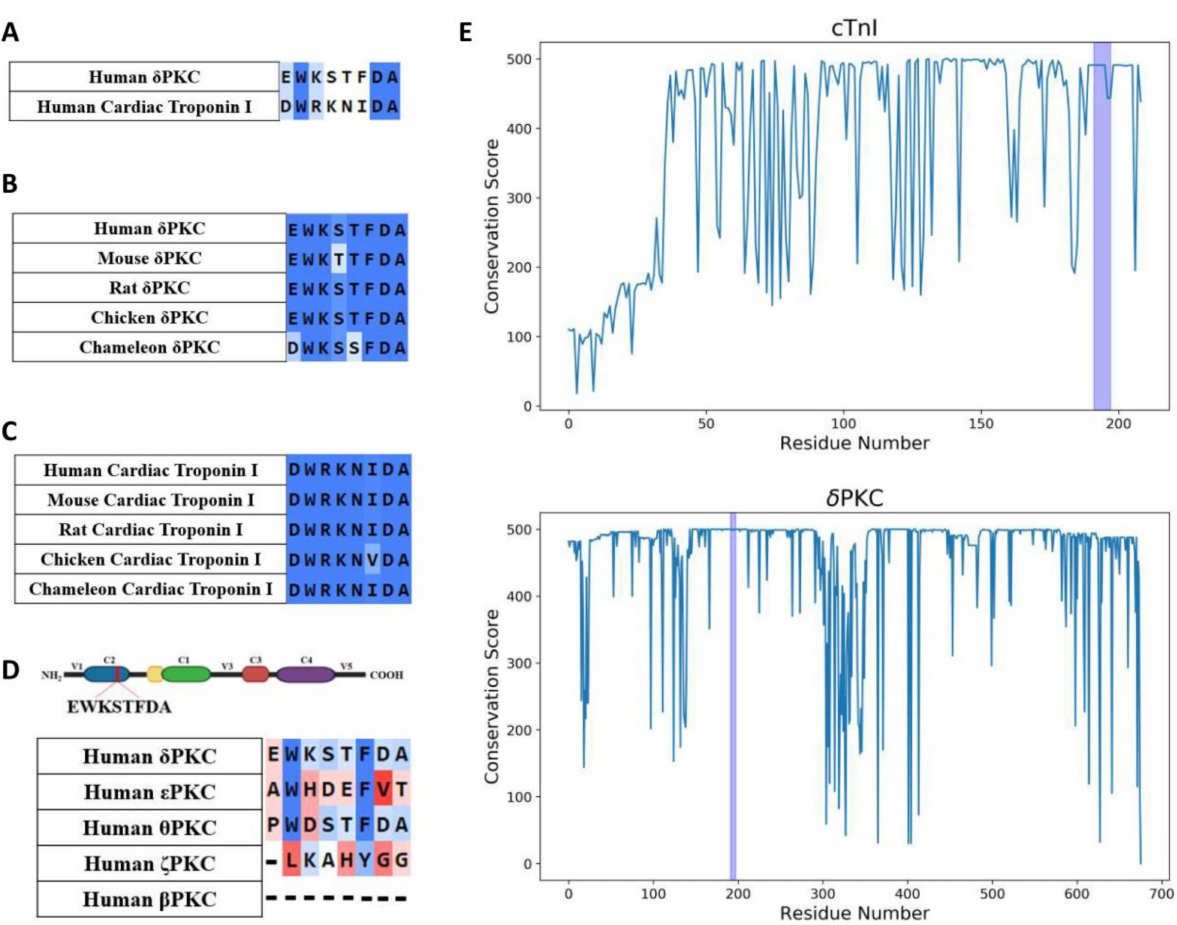
Figure 1. ψ TnI sequence is highly conserved. Sequence alignment identifies a short sequence of homology between the C terminus of human cTnI and δ PKC C2 domain ( A ) that is conserved in evolution ( B , C ), but is absent in other PKC isozymes ( D ). In ( E ), conservation is measured by the number of identical or similar residues compared to the human cTnI ( top ) and δ PKC ( bottom ) gene. Blue regions represent the sequences corresponding to ψ TnI in cTnI and δ PKC,